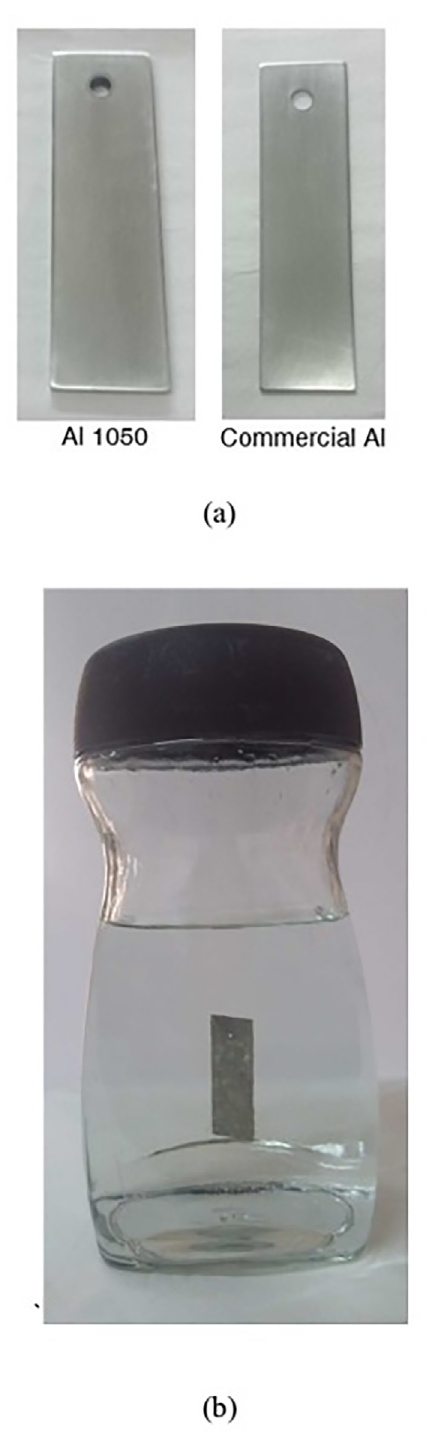
Figure 1. (a) Test pieces for weight loss assays. (b) Container for testing of weight loss and disposition of the test pieces.